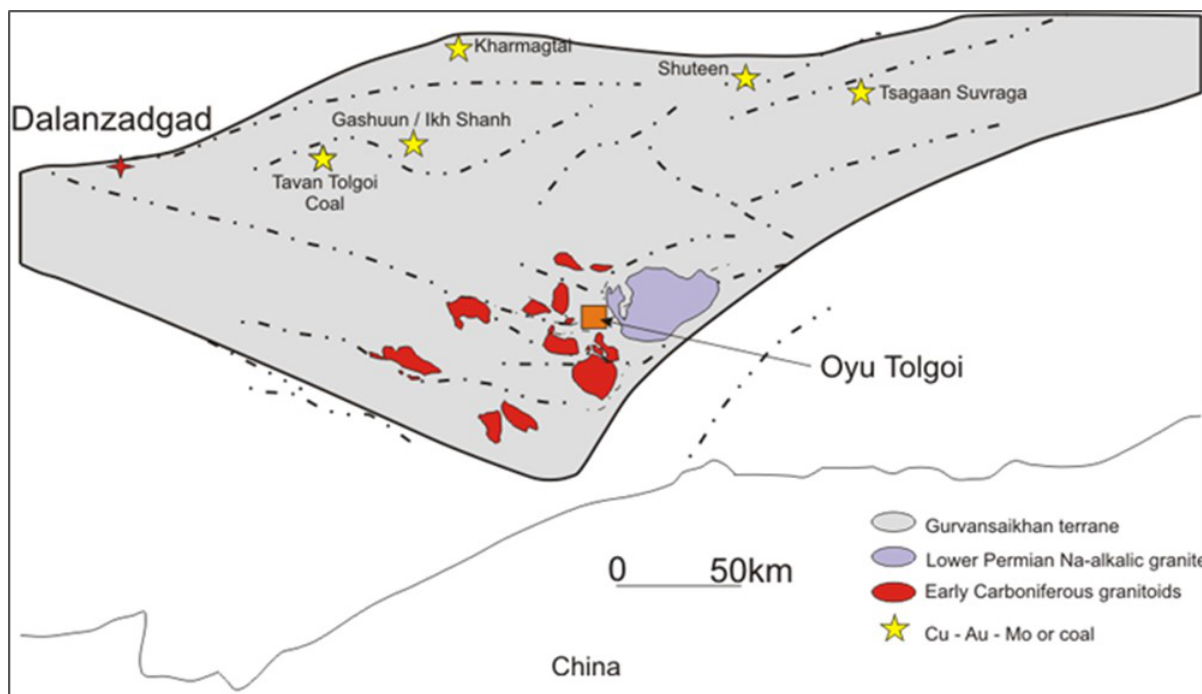
Fig. 1. The location of Oyu Tolgoi deposits in Gurvansaikhan Island Arc terrain